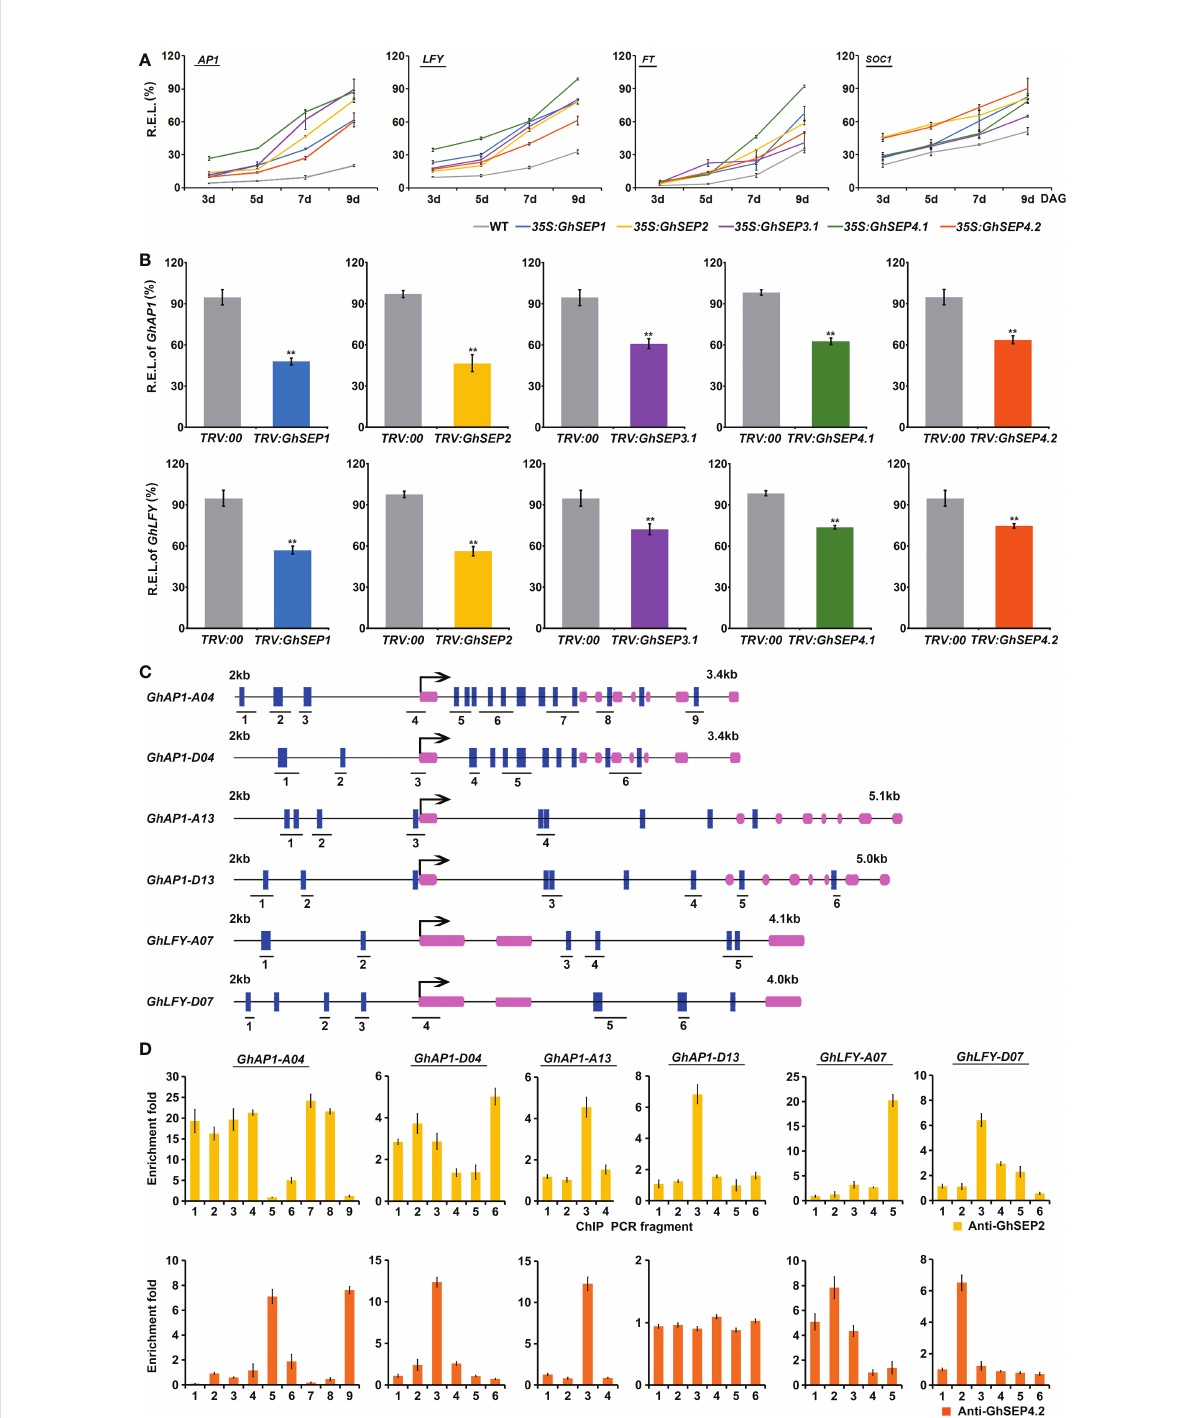
FIGURE 5 GhSEPs directly regulate GhAP1 and GhLFY . (A) Temporal expression of AtAP1 , AtLFY , AtFT , and AtSOC1 in Arabidopsis developing seedlings of WT and 35S:GhSEP plants. (B) Expression of GhAP1 and GhLFY in cotton-silencing lines and control plants. Asterisks indicate signi fi cant differences according to Student ’ s t -test at p ≤ 0.01. (C) Prediction of the CArG box in the genome regions of GhAP1 and GhLFY . Exons are represented by purple boxes, and the other genomic regions are represented by black lines. Blue boxes indicate the sites containing either a single mismatch or a perfect match to the consensus binding sequence (CArG-box) of MADS-domain proteins. The number under the schematic diagram means the DNA fragments designed for the ChIP analysis of the GhSEP binding site as shown in (D) . kb, kilobase. (D) ChIP analysis of GhSEP binding to the GhAP1 and GhLFY genomic regions. Error bars denote